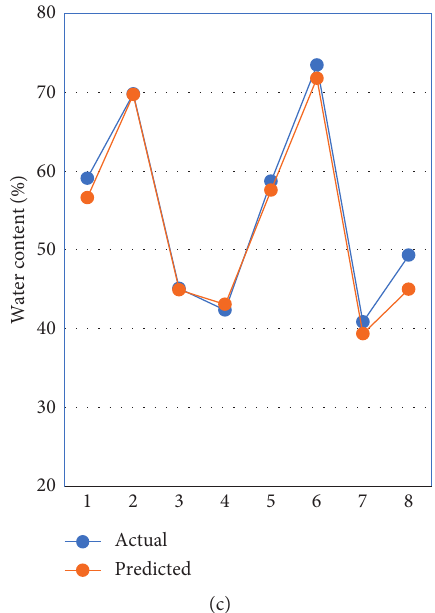
Figure 5: Actual versus predicted values for (a) amine, (b) CO